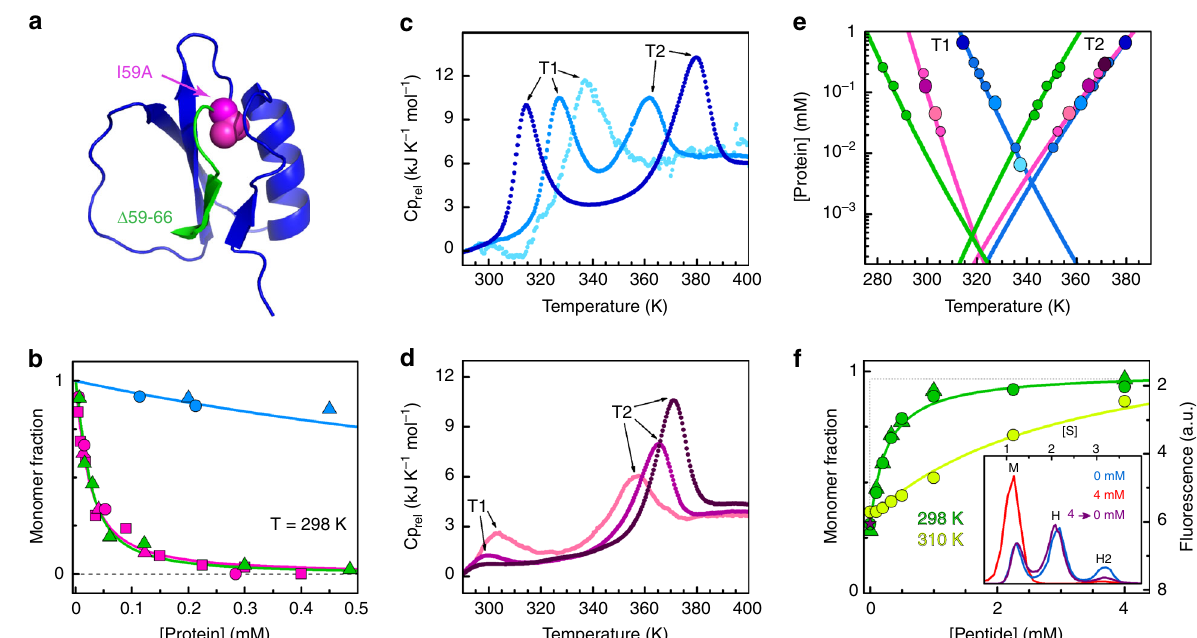
Fig. 7 Optimization and allosteric control of assembly. a Promoting assembly by enhancing the fold-switch transition: (magenta) I59A mutation on CI2 eng , (green) 59 – 66 truncation on wild type. b Monomer fraction versus protein concentration for CI2 eng (blue), I59A-CI2 eng (magenta), and CI2 1 – 58 (green). c DSC thermograms of CI2 eng at different protein concentrations. d As c for I59A-CI2 eng . e Protein concentration versus position of exothermic peaks from DSC (color as b ). Data from c and d are indicated as larger circles of the same color shade. f Monomer recovery versus concentration of C-peptide for CI2 1 – 58 at 80 μ M. (Inset) distribution of CI2 1 – 58 monomer (M), hexamer (H), and dodecamer (H2) at 0 mM (blue) and 4 mM (red) C-peptide, and at 4 mM after dialysis (purple, star) obtained by analytical ultracentrifugation. In b , f , triangles represent analytical ultracentrifugation, circles size-exclusion chromatography, and squares circular dichroism